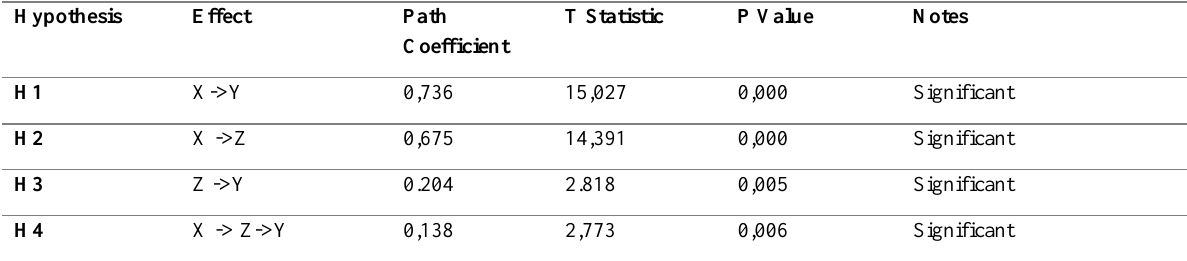
Table 6: Hypothesis Testing